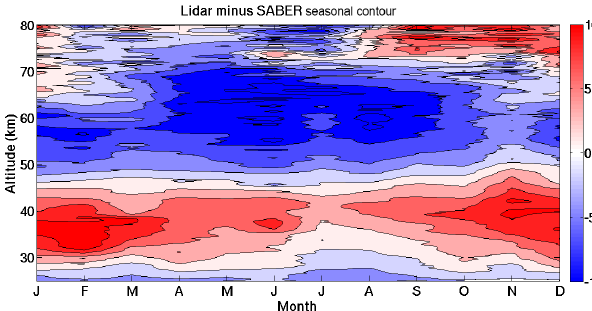
Figure 4. Monthly median temperature difference between li- dar and SABER temperature measurements. Red indicates regions where the lidar measures warmer temperatures than SABER and blue regions where the lidar measures colder temperatures than SABER.